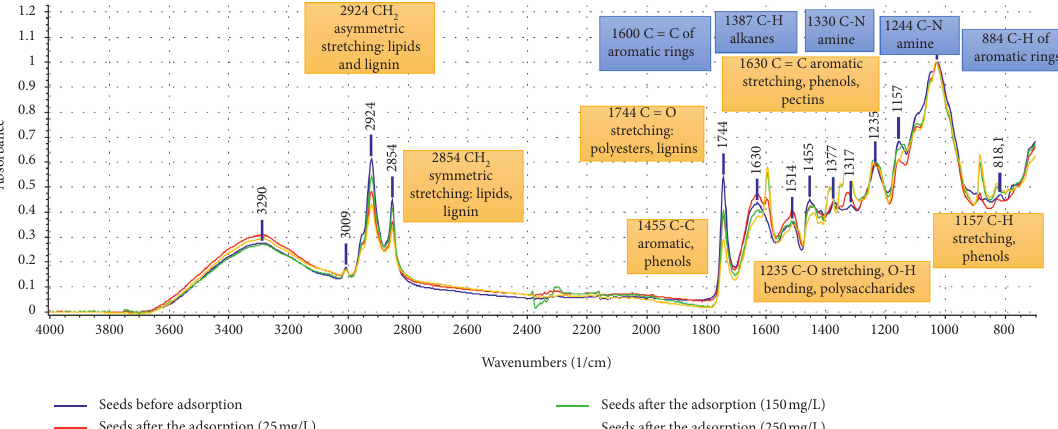
Figure 8: FTIR spectrum of nance seeds before and after MB adsorption (pH 7). Blue tags correspond to functional groups of MB. Orange tags correspond to functional groups of the seeds.